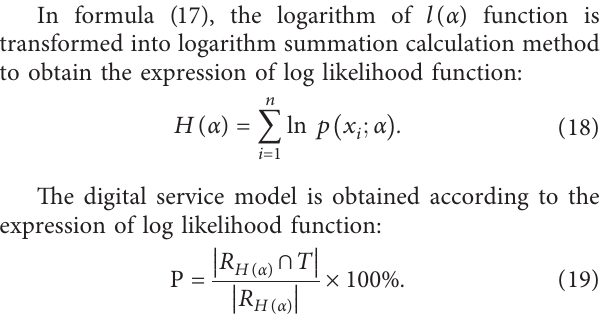
Figure 3: Red education resource data index